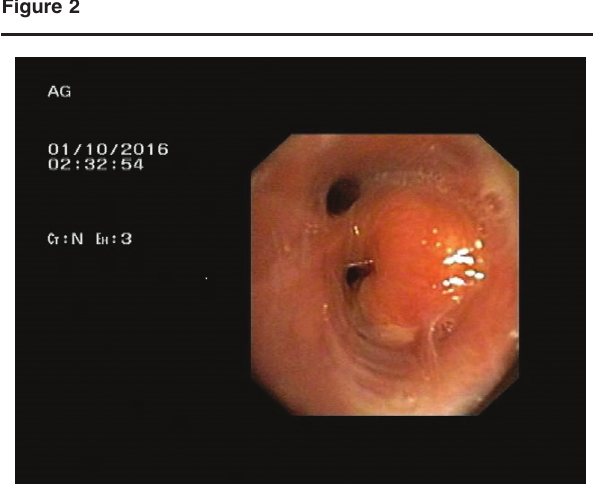
Smooth polypoidal mass occluding the anterior and apicoposterior segment of the left upper